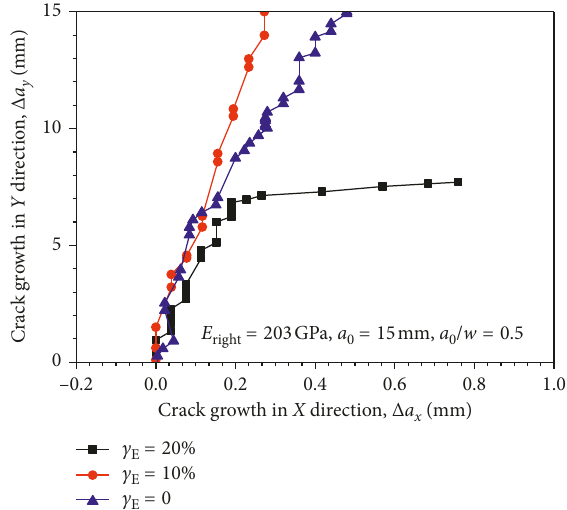
Figure 12: Crack extension paths of elastic modulus mismatch specimen.